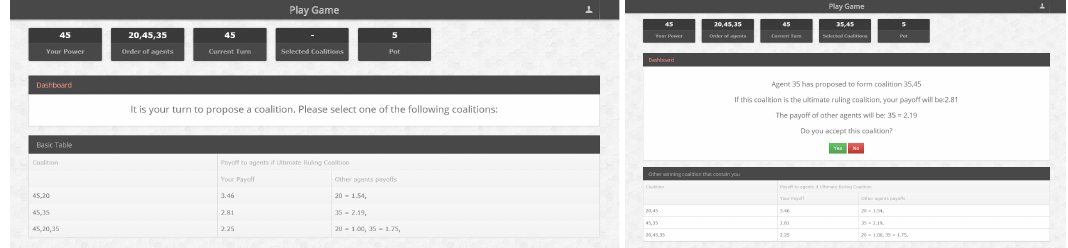
Figure 1. A screenshot of the proposal ( left panel ) and response stage ( right panel